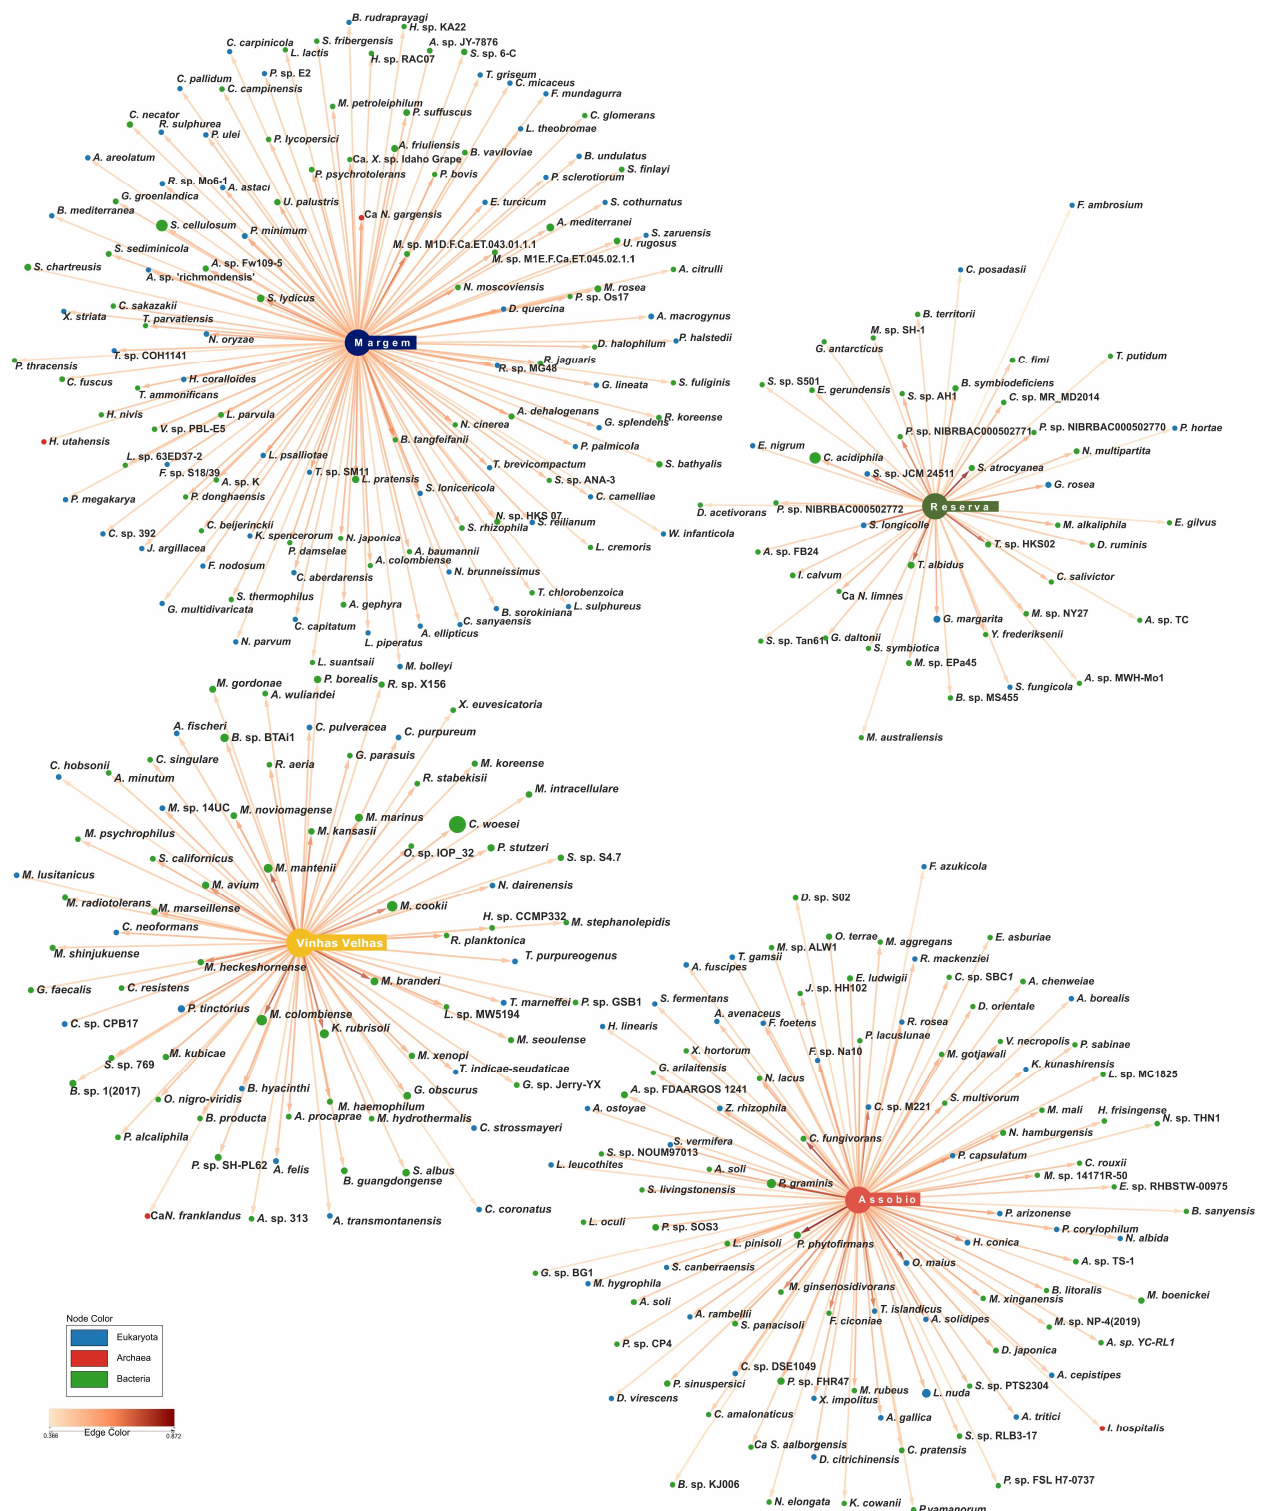
Figure 5. Association network of species in different Terroirs. The association network was calculated in the R package indicspecies [30]. Node size correspond to the relative abundance of the species in the terroirs, and the colour represent the kingdom that they belong to. Edge length and colour represent the strength of the association (edge-weighted, spring-embedded layout).